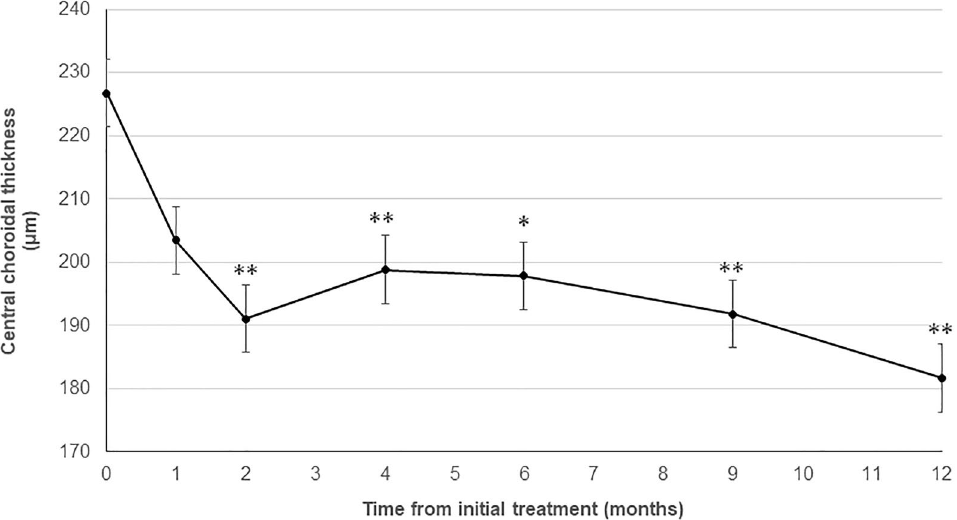
Figure 3. Changes in the central choroidal thickness (CCT) during the 12-month follow-up period. The mean CCTs at 4, 6, and 12 months decreased significantly compared with baseline (* P < 0.05, ** P <